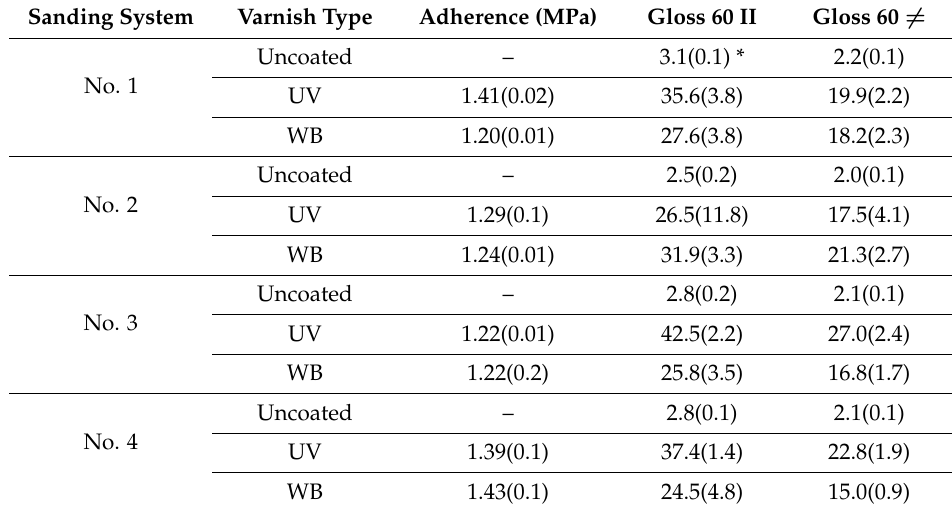
Table 4. Average values of adherence and gloss at 60 ◦ as a function of the sanding system and varnish type. Sanding